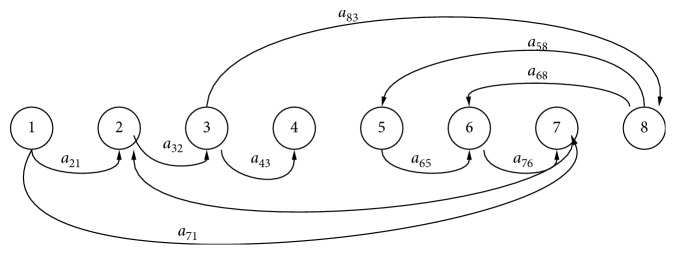
Weighted digraph (G, A) constructed for models (3)–(10).